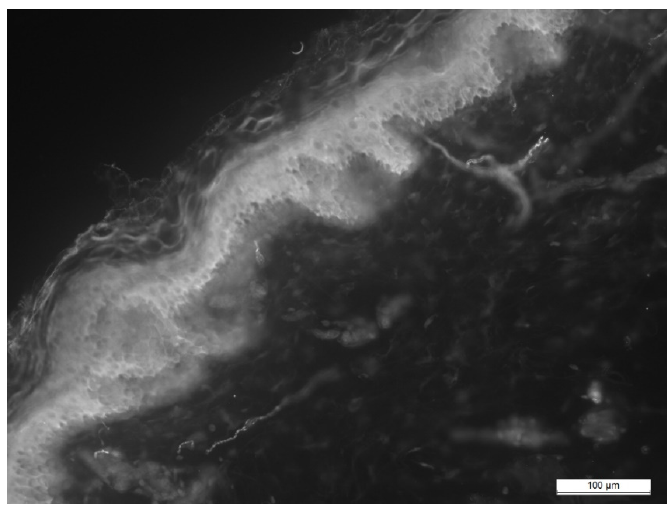
Figure 1. Skin biopsy of patient with sarcoidosis (enzyme immunoassay, male, 34 years). Arrows indicate small fibers in the epidermis of the skin.